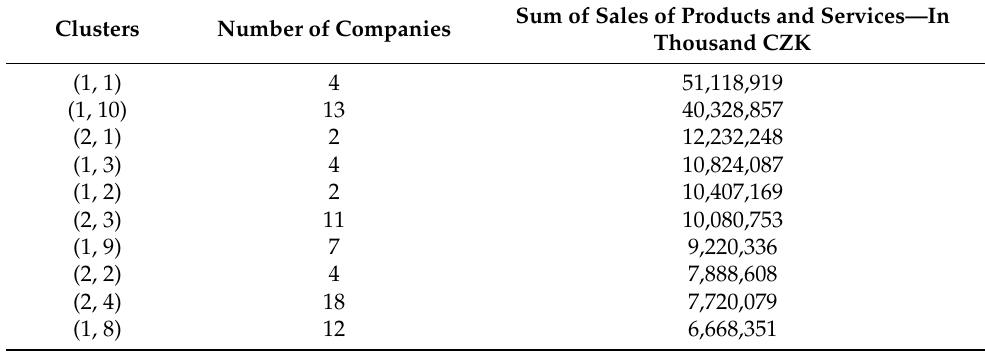
Table 18. Table of ten clusters with the highest total sum of fixed assets for the year 2016. Clusters